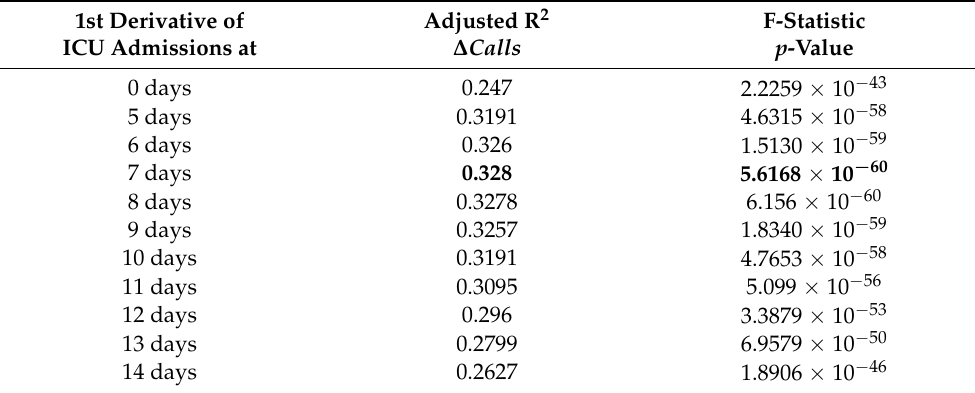
Table 2. R 2 and p -values for univariate regression models between ∆ Calls and first order derivative of ICU admissions in Lazio Region, Italy, 2020–2021. Most informative value results are in bold. ICU: Intensive Care Unit.